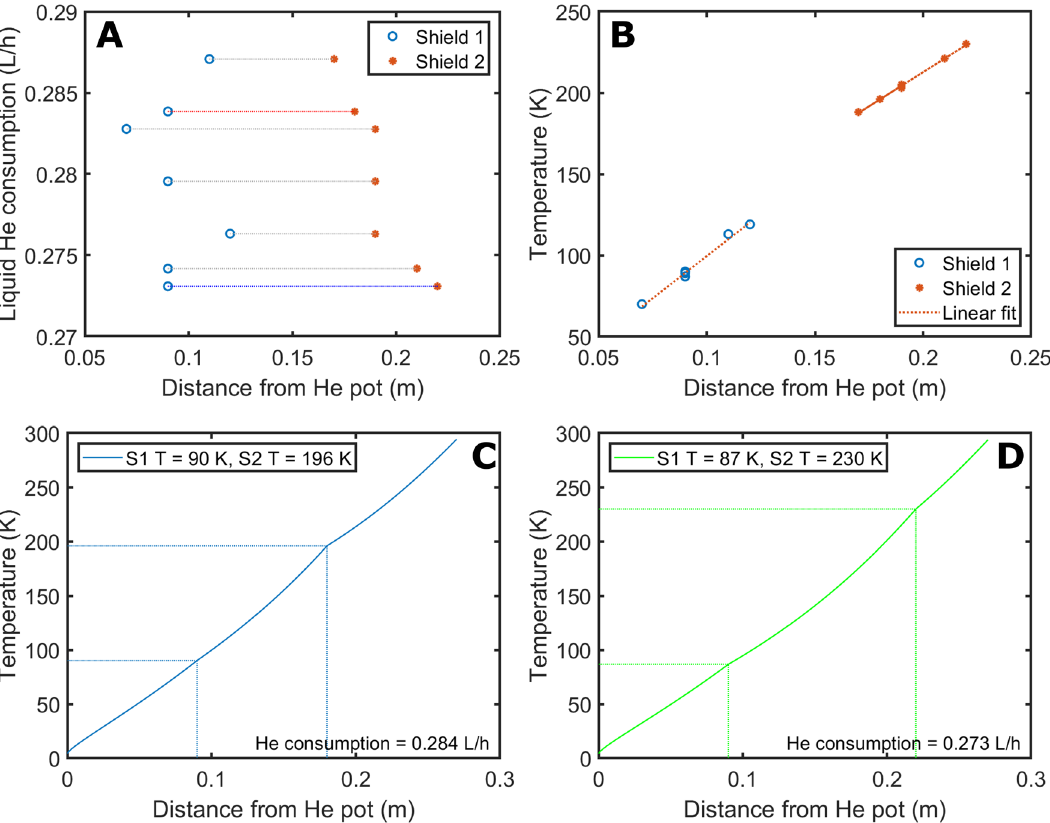
Figure 6. Liquid He consumption as a function of the shields position; the blue circles and the stars represent shield 1 and shield 2, respectively; shields positions leading to a solution of Eq. (4) for a given gas flow are connected by horizontal lines: the one in red corresponds to the shields places at 1/3 and 2/3 of the neck length, while the one is blue is the configuration providing the lowest consumption ( A ). Shield 1 and shield 2 temperatures as a function of their positions; in both cases data were fit using a linear relation ( B ). Temperature profile corresponding to the “non optimized” configuration ( C , red line in A ) and the best configuration ( D , blue line in A ).